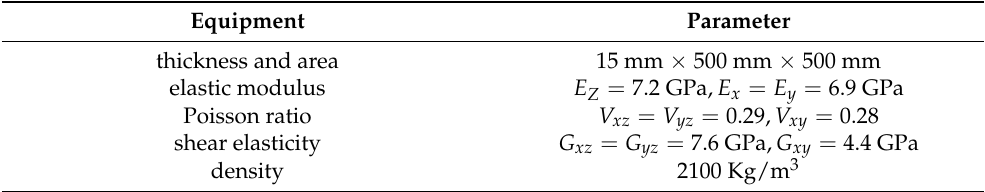
Table 1. Parameters of composite plates.